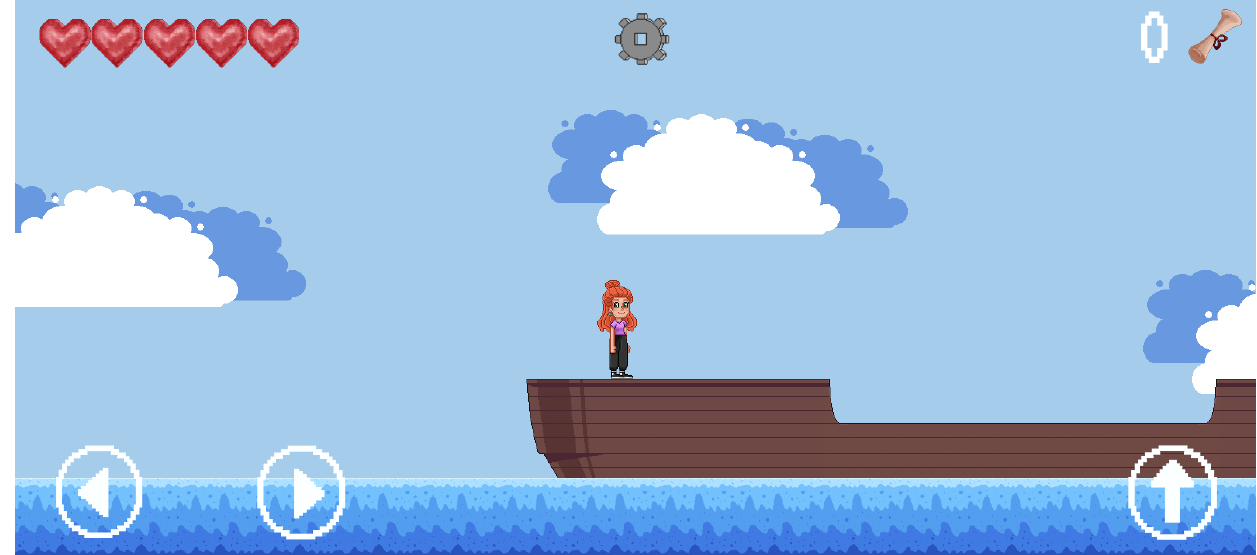
Figure 8. Screenshot of Phase 4.